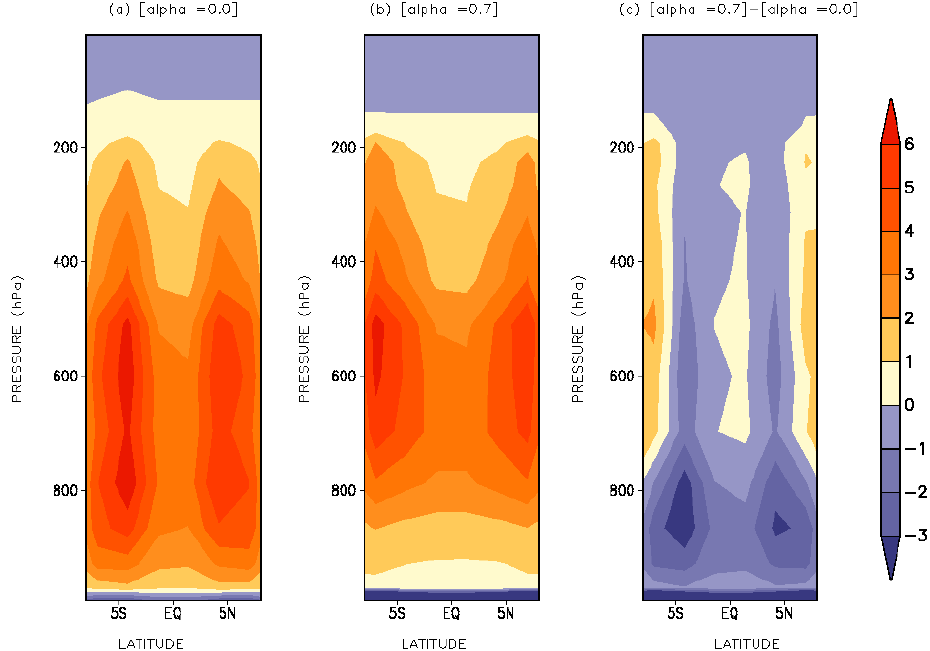
Fig. 11. Zonally averaged time mean temperature tendency due to ZM moist convection scheme (K/day) (a) α =0.0, (b) α =0.7, and (c) ( α =0.7)–( α =0.0).